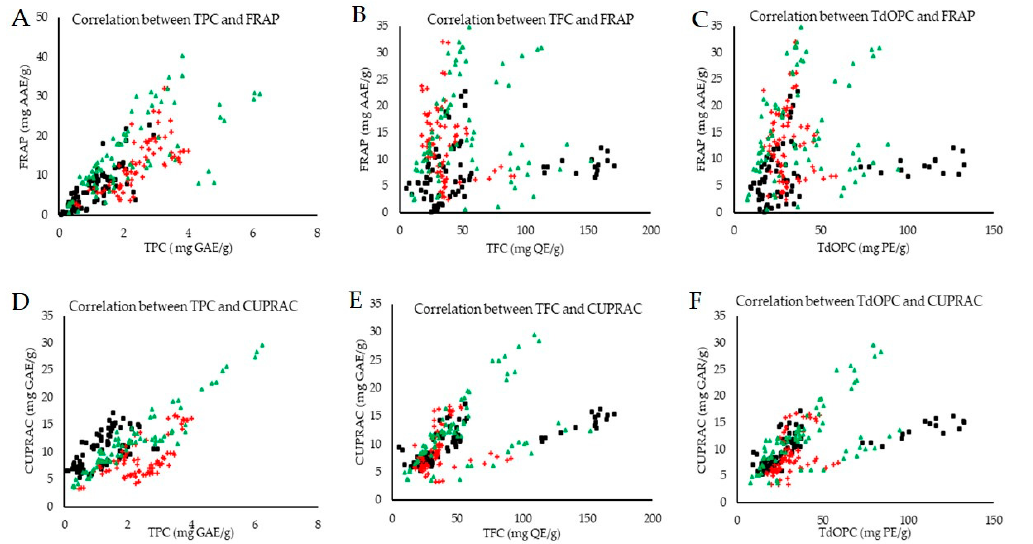
Figure 10. ( A ) Correlation between TPC and FRAP. The ρ -value of methanolic extracts ( ■ ) was 0.78, for acidic hydrolysis (+) it was 0.80 and for alkaline hydrolysis ( ▲ ) it was 0.76. ( B ) Correlation between TFC and FRAP. The ρ -value of methanolic extracts ( ■ ) was 0.45, for acidic hydrolysis (+) it was -0.35 and for alkaline hydrolysis ( ▲ ) it was 0.052. ( C ) Correlation between TdOPC and FRAP. The ρ -value of methanolic extracts was 0.46, for acidic hydrolysis (+) it was 0.06 and for alkaline hydrolysis ( ▲ ) it was 0.25. ( D ) Correlation between TPC and CUPRAC. The ρ -value of methanolic extracts ( ■ ) was 0.69, for acidic hydrolysis (+) it was 0.57 and for alkaline hydrolysis ( ▲ ) it was 0.93. ( E ) Correlation between TFC and CUPRAC. The ρ -value of methanolic extracts ( ■ ) was 0.84, for acidic hydrolysis (+) it was 0.48 and for alkaline hydrolysis ( ▲ ) it was 0.63. ( F ) Correlation between TdOPC and CUPRAC. The ρ -value of methanolic extracts was 0.83, for acidic hydrolysis (+) it was 0.58 and for alkaline hydrolysis ( ▲ ) it was 0.69.